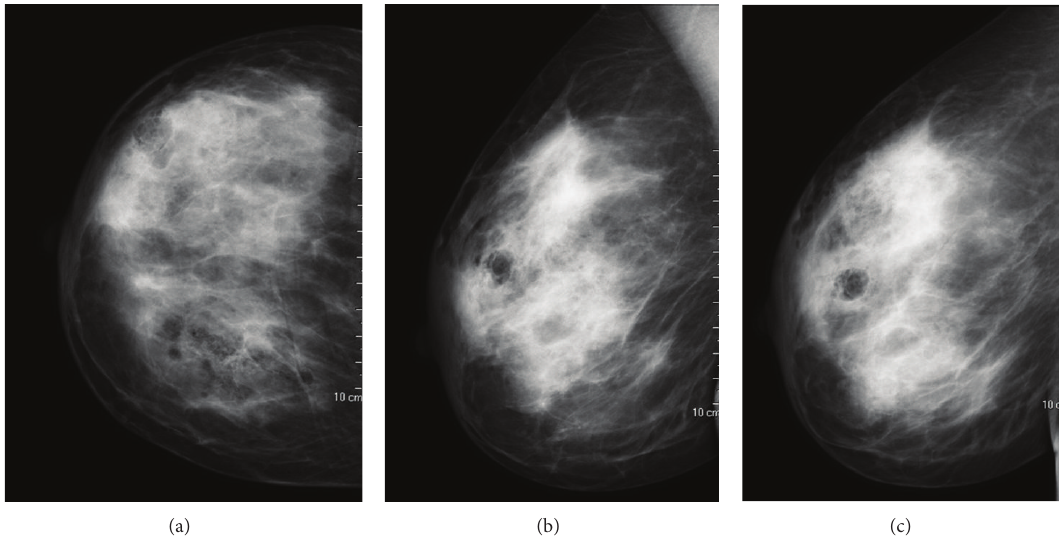
Figure 3: Right craniocaudal projection (a), mediolateral oblique projection (b), and mediolateral projection (c) show diffused increased parenchymal density and increased skin thickening in the areolar region.